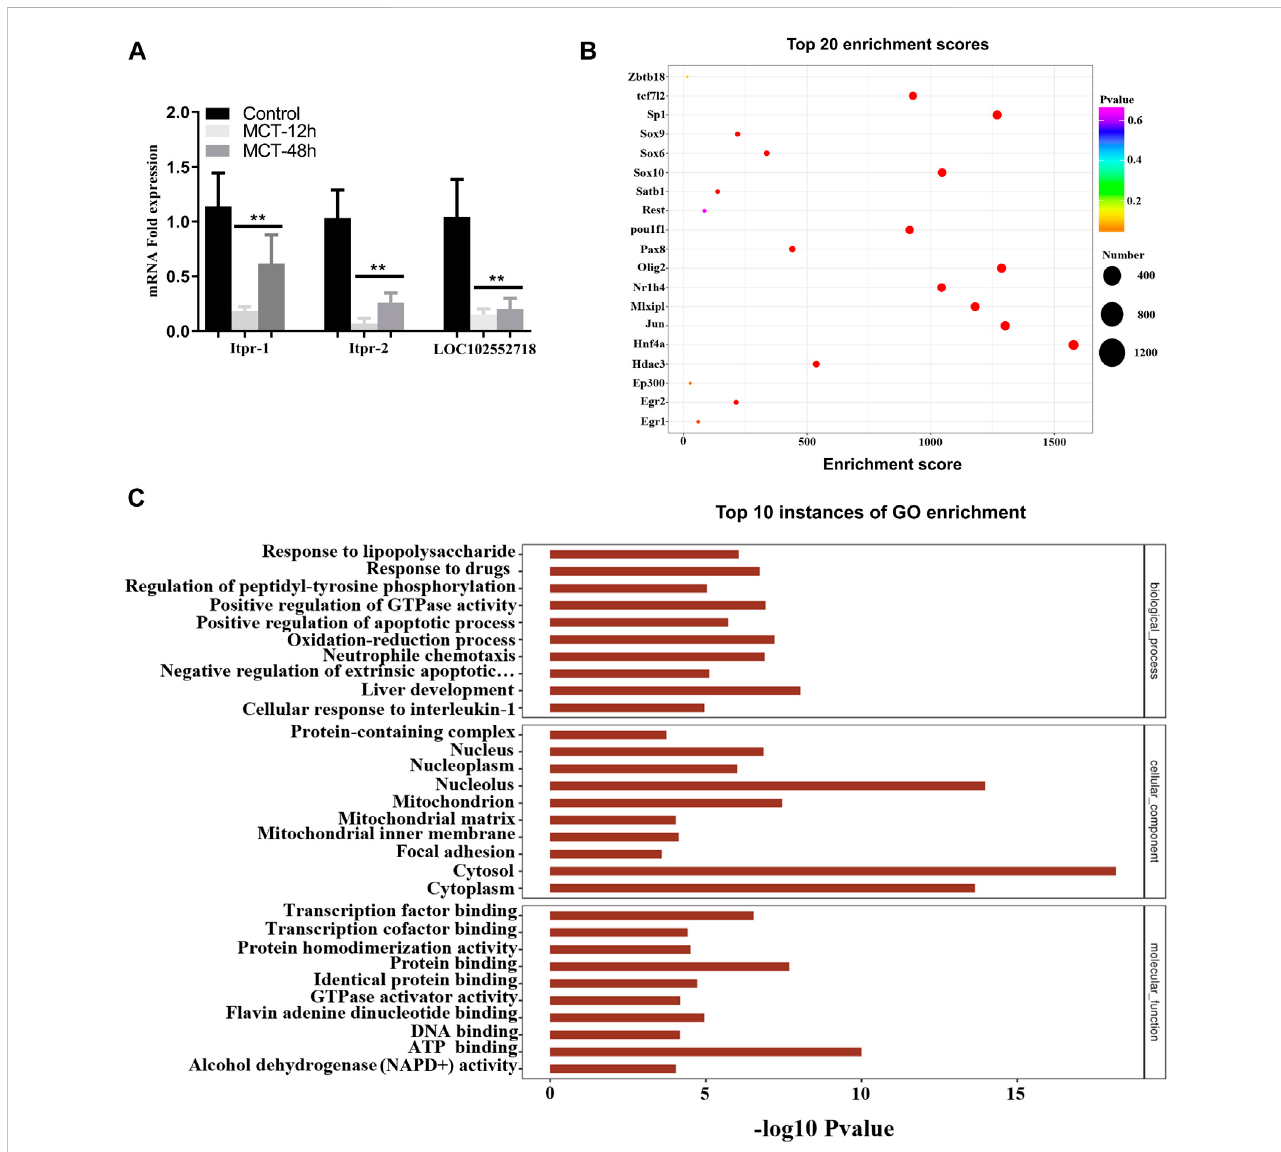
FIGURE 7 Hypothesized function of LOC102552718 in hepatotoxicity induced by MCT. (A) Relative expression of Itpr1, Itpr2, and LOC102552718 in control and MCT-treated liver tissue. Data are presented in the form mean ± SD. n = 6 rats per time point. (B) Bubble chart of the top 20 enriched transcription factors associated with LOC102552718 . The X -axis represents enrichment score. The larger the bubble, the higher the number of differentially expressed genes encoding the protein. Bubble color indicates the p -value for enrichment: the smaller the p -value (i.e., the greater the signi fi cance), the further the color along the scale from purple to blue to green to red. (C) Top 10 GO enrichment scores for LOC102552718 . The Y -axis represents -log10 ( p -value); the longer the bar, the smaller the corresponding p -value. (D) Top 10 KEGG enrichment results for differentially expressed genes co-expressed with LOC102552718 , highlighting the top 10 entries with the smallest p -values for several KEGG primary classi fi cations (Cellular Processes, Environmental Information Processing, Genetic Information Processing, Human Diseases, Metabolism,and Organismal Systems).The X -axis represents enrichment score.The largerthebubble, the higher the number of differentially expressed genes. Bubble color ranges from gray to red as the p -value representing enrichment decreases (i.e., as signi fi cance level increases). * p ≤ 0.05; ** p ≤ 0.01; *** p ≤ 0.001 in comparisons of the MCT-treated group against the control group. Colors differentiate BPs, CCs, and MFs. BP, biological process; CC, cellular component; MF, molecular